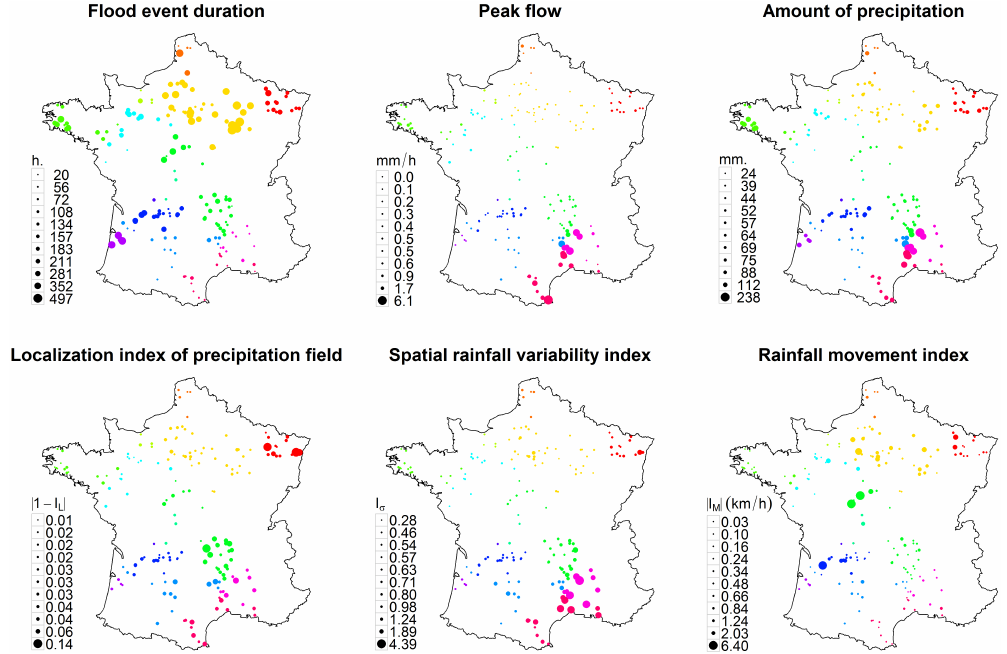
Fig. 7. Event characteristics averaged over the 20 flood events observed in each of the 181 catchments. The peak flow coefficient is the ratio between the peak flow and the mean flow. The colors refer to geographic